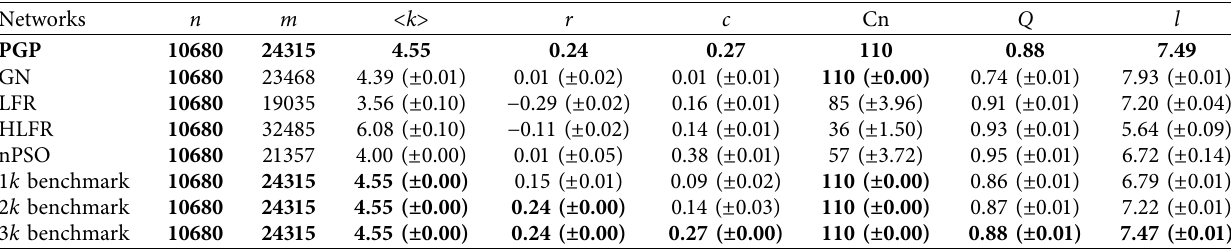
Table 4: Structural characteristics of the original PGP network and seven kinds of generated benchmarks. Each data represents the average value of the characteristic calculated on 100 generated benchmarks and the data in parentheses represents the corresponding standard deviation. Note that the best results closest to the original karate network on each characteristic are highlighted in bold. Networks